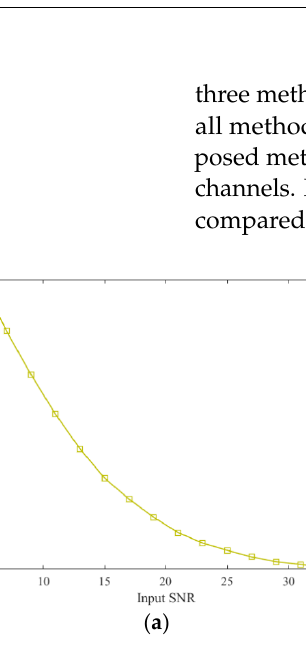
Figure 10. The impact of low-rank feature on SNR improvement of PN signal and CIR estimation: ( a ) SNR improvement of PN signal; ( b ) MSE performance of CIR estimation.